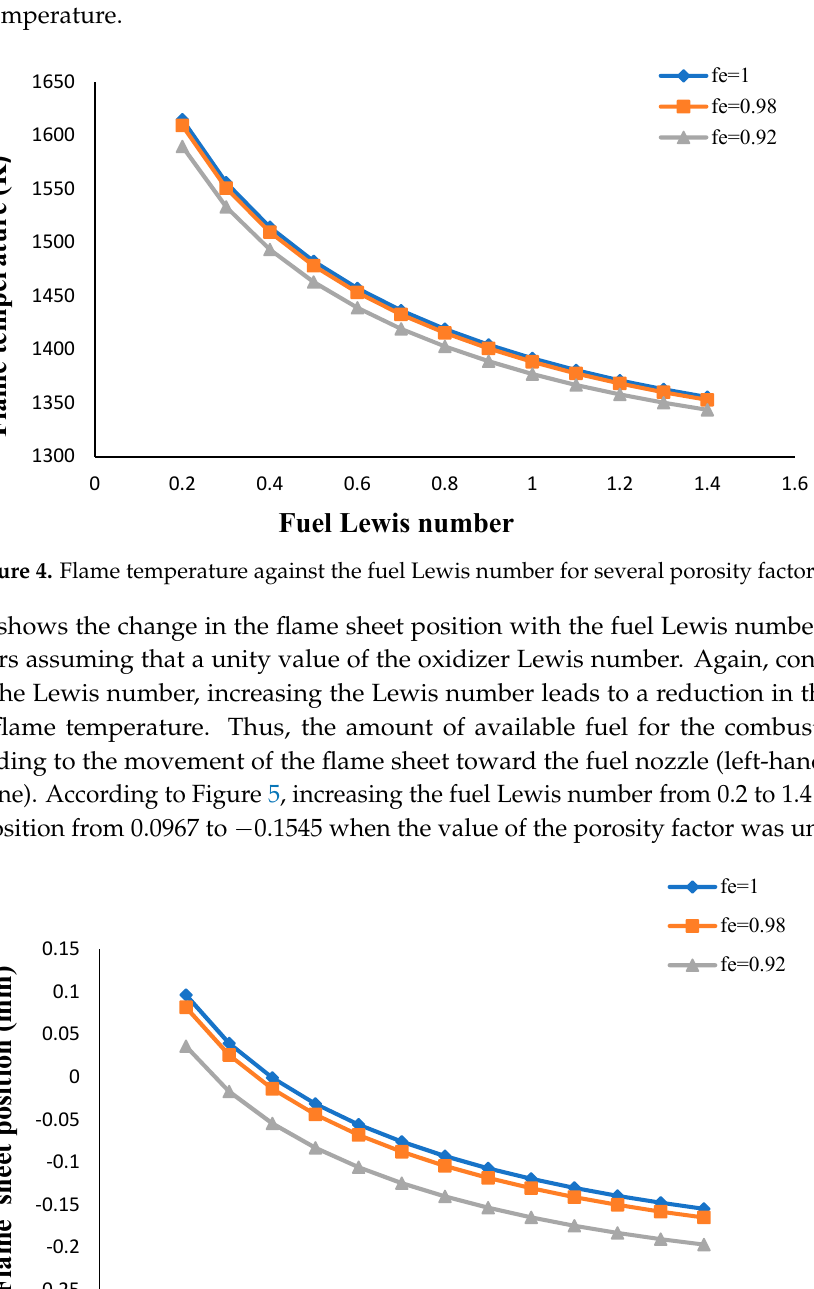
Figure 6. Flame temperature against the oxidizer Lewis number for several porosity factors. Figure 7 represents the change in the flame sheet position with the oxidizer Lewis number for different porosity factors and a unity magnitude of the fuel Lewis number. According to the figure, an increment in the oxidizer Lewis number caused a rise in the value of the flame sheet position. In other words, the flame sheet shifted toward the oxidizer nozzle. Based on the Lewis number formula, increasing the oxidizer Lewis number reduces the mass diffusivity of oxidizer. Accordingly, the flame sheet moved toward the oxidizer zone. Regarding Figure 7, for the